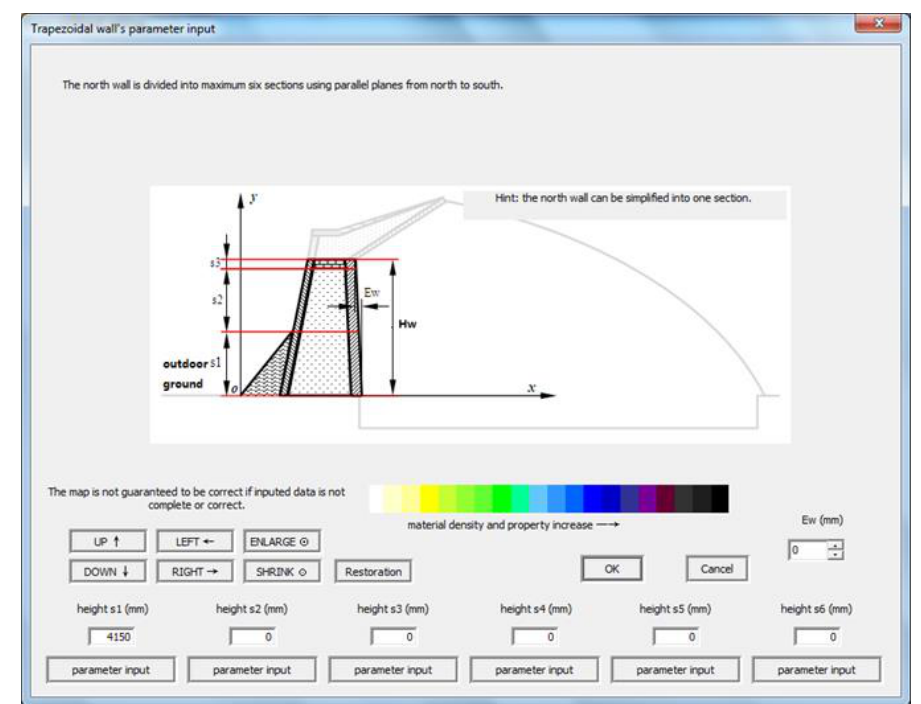
Figure 3. The interface for defining the physical properties of the north wall.